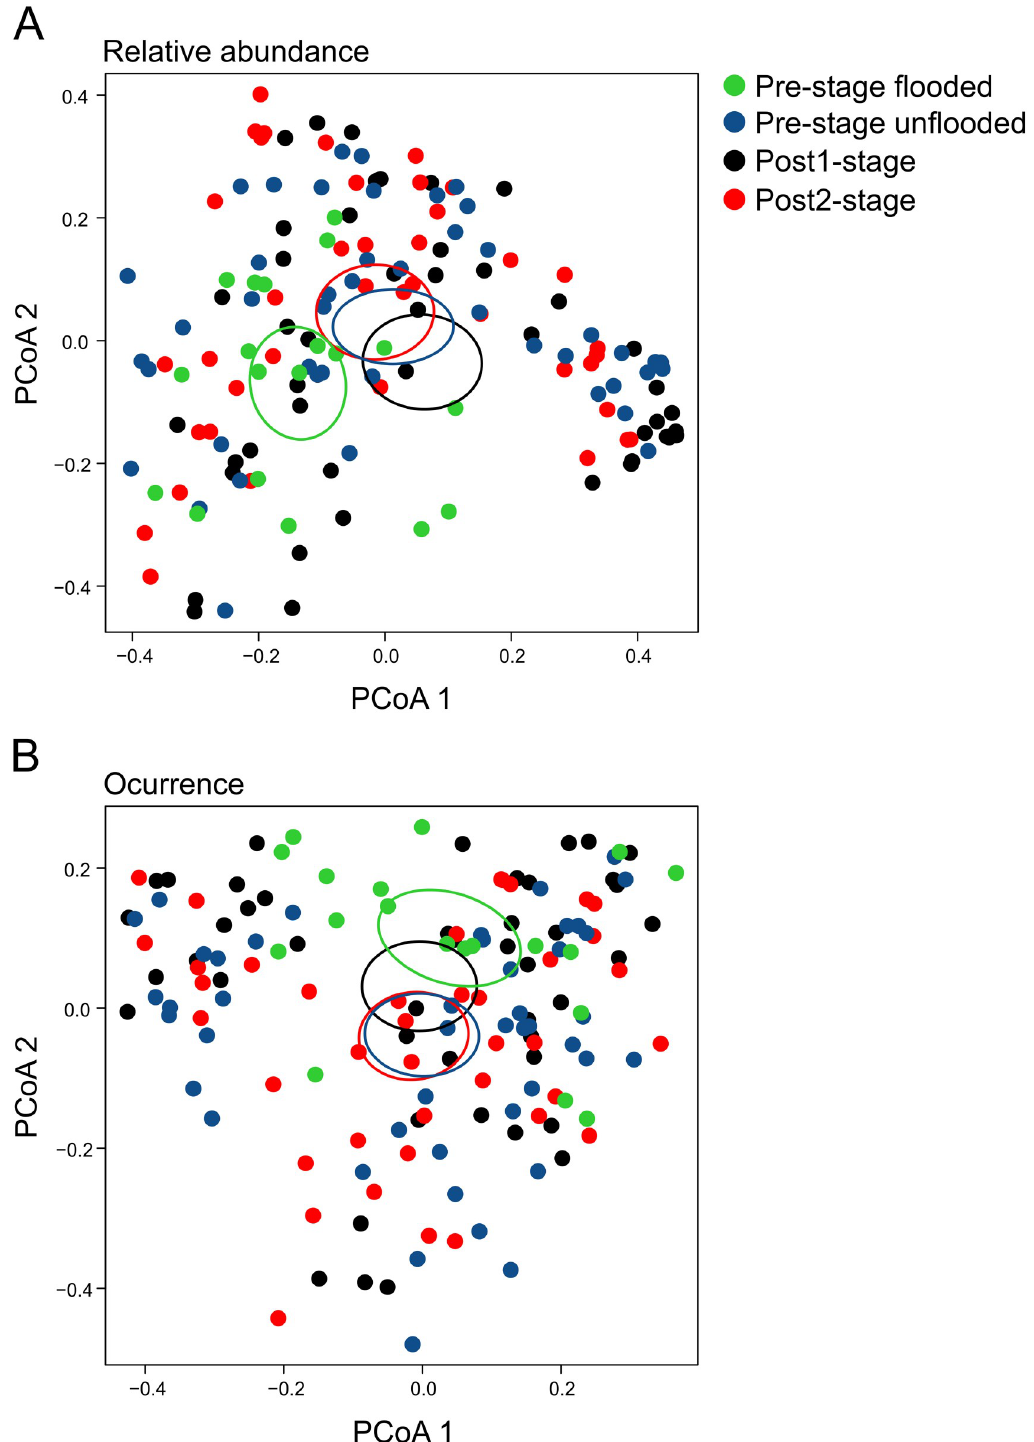
Fig 4. First two axes of a principal coordinates analysis (PCoA) based on relative abundance (A) and occurrence (B) of frog species showing the 95% confidence ellipses for the centroids of samples in plots in relation to inundation and time since filling of the Santo Antoˆnio dam on the Madeira River, southwestern Brazilian Amazonia. green = plots that were sampled pre-filling that were flooded; blue = plots that were sampled pre-filling that were not flooded; black = plots sampled 1 year after dam filling; red = plots sampled 4 years after dam